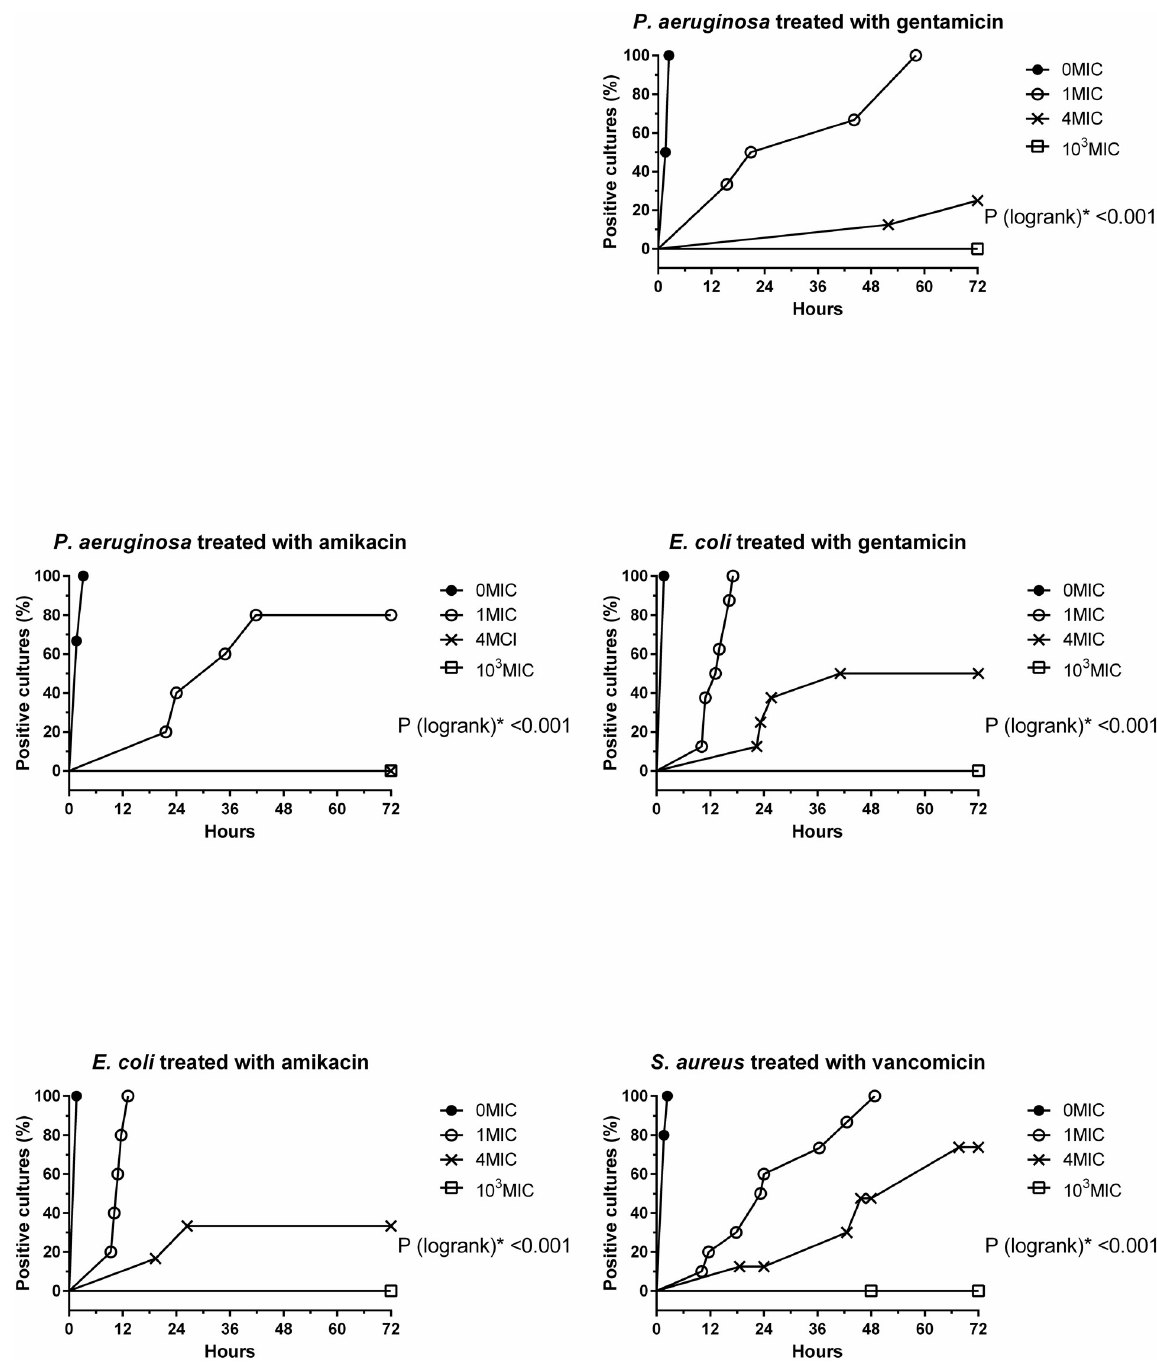
Fig 2. Percent of positive cultures following exposure to different antibiotic concentrations. � P (logrank) comparison between 1MIC and 10 3 MIC.